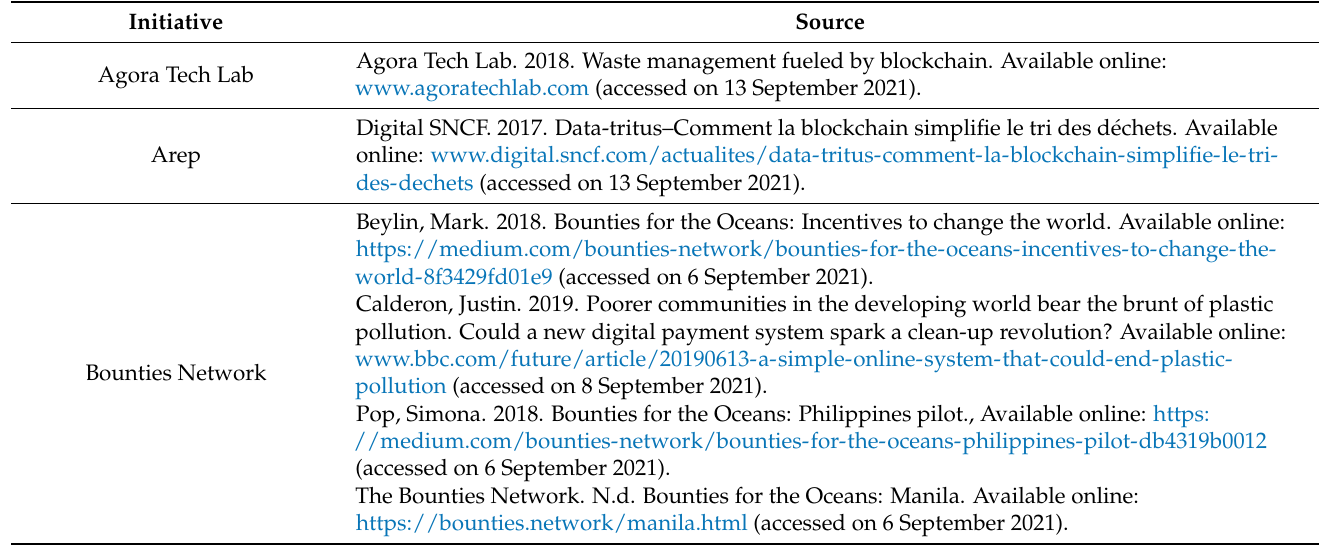
Table A1. Source material for blockchain technology-based waste management initiatives. Initiative Source Agora Tech